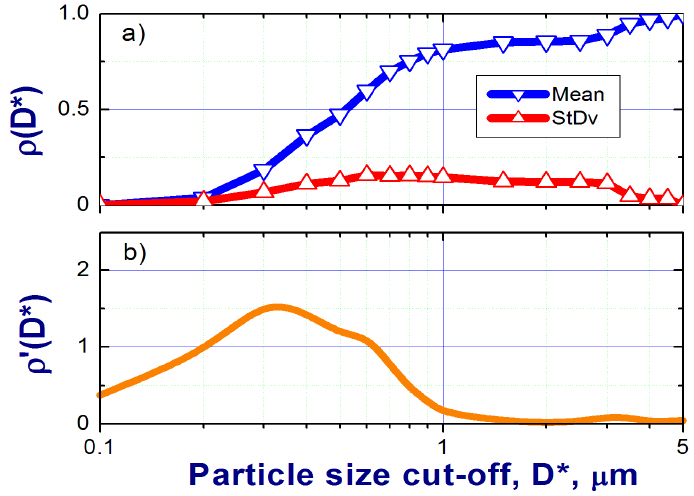
Figure A1. The normalized scattering coefficient ( a ) and its derivative ( b ) as a function of particle size cut-off. The blue line shows the mean for all TCAP flight legs and the red line represents the corresponding standard deviations.